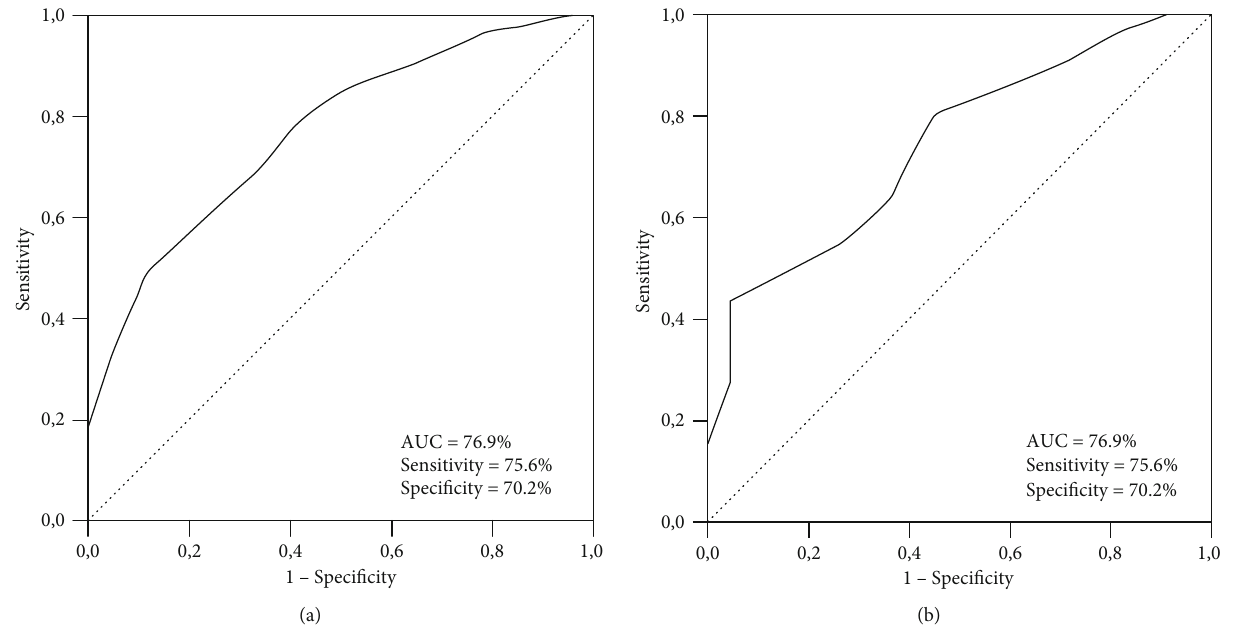
Figure 1: Receiver operating curve analyses outcomes: (a) progression-free survival, and (b) overall